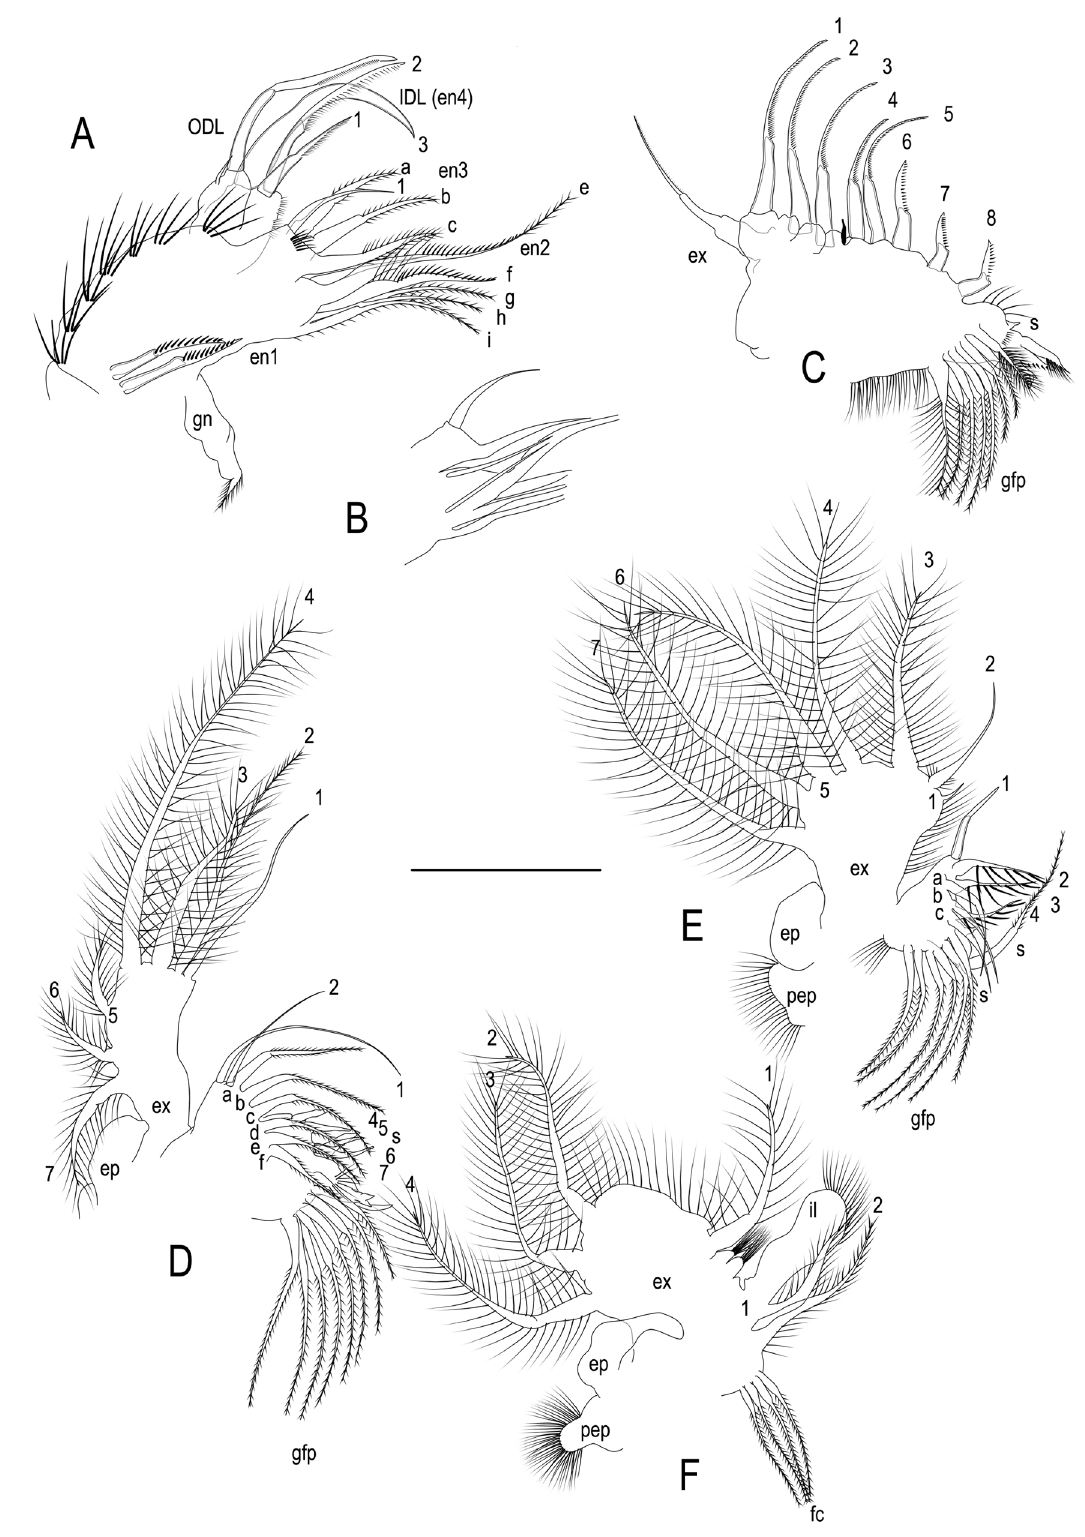
Fig. 11. Disparalona ( Mixopleuroxus ) tenuispina sp. nov., parthenogenetic female. A . First limb. B . Idem , stiff setae. C . Second limb. D . Third limb. E . Fourth limb. F . Fifth limb; Scale bar = 50